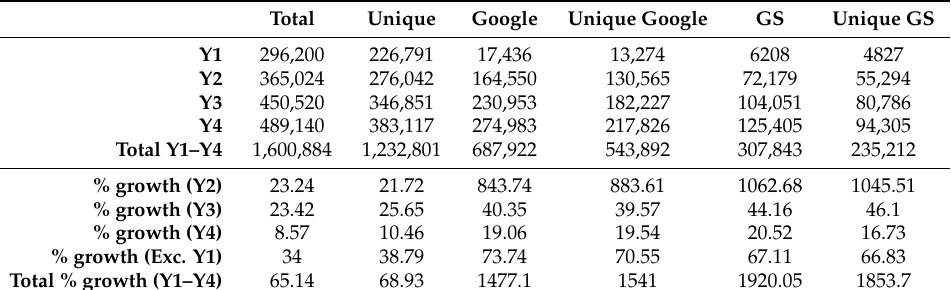
Table 2. Data table of total and unique web traffic to Strathprints during Y1–Y4, alongside total and unique traffic referred via Google and Google Scholar (GS).